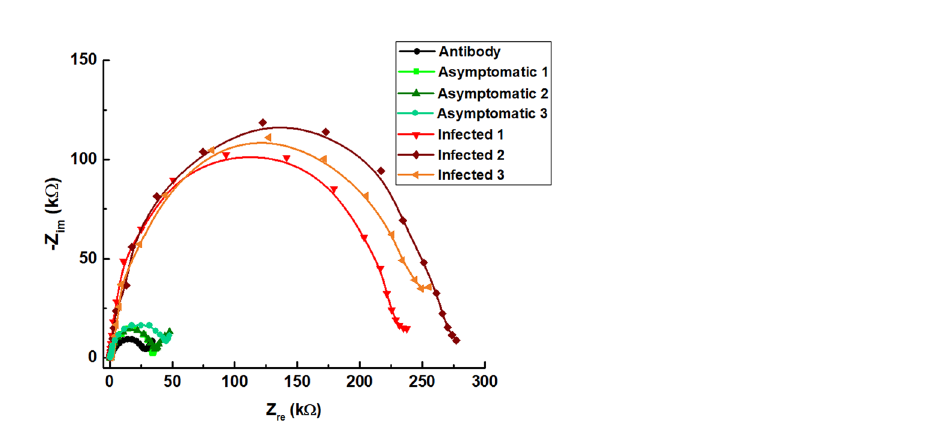
Figure 6. EIS spectra obtained by testing asymptomatic and infected trees with LOC device.